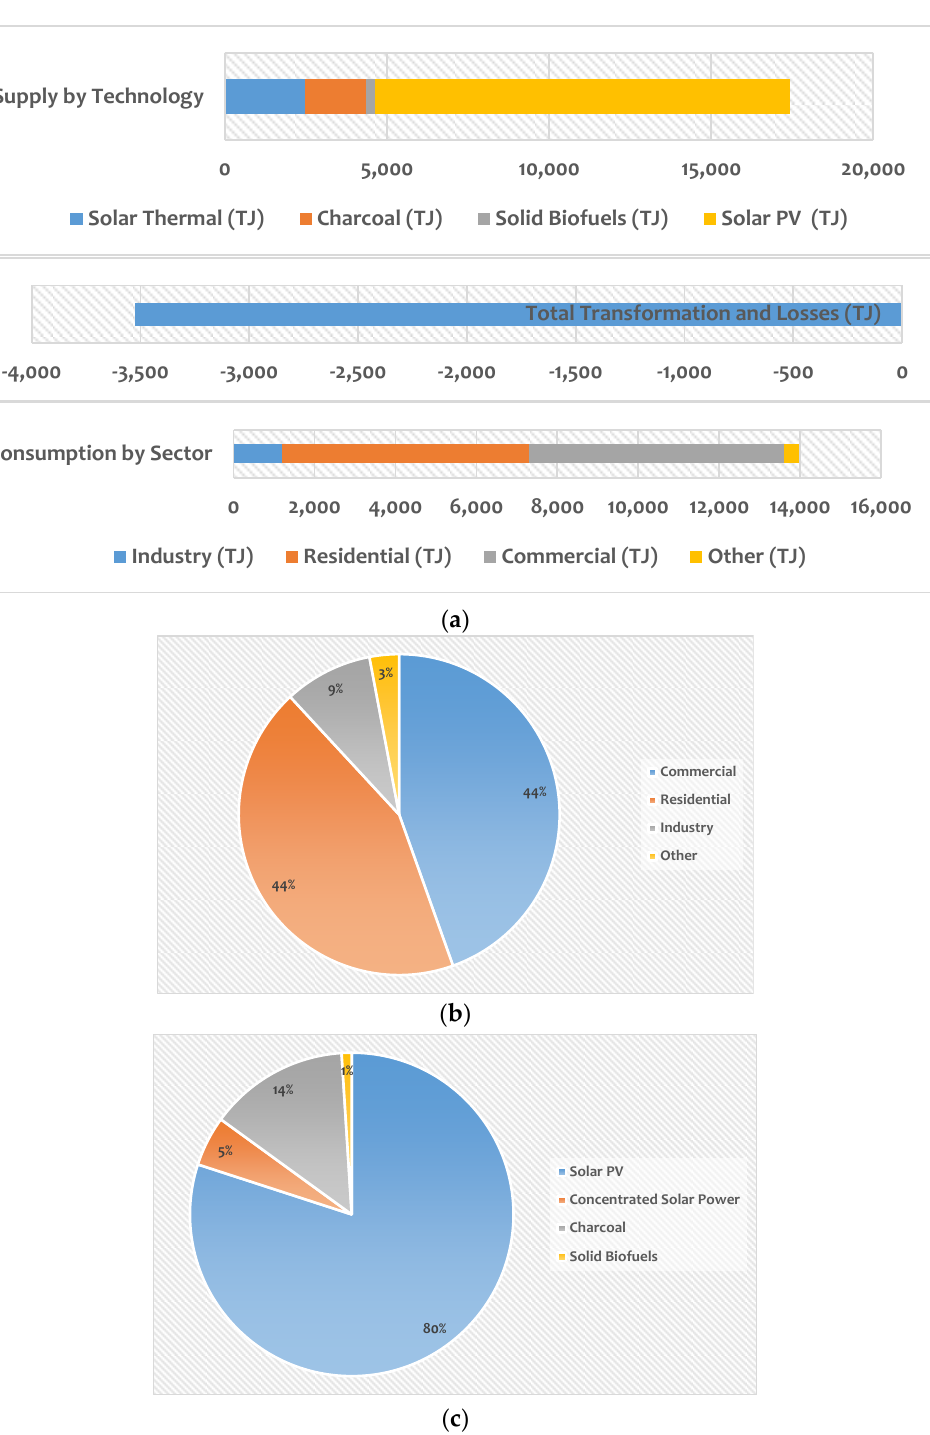
Figure 4. ( a ) Renewable energy balance in the UAE (2019). Data were collected from [15]; ( b ) final renewable energy demand by UAE economic sector (2019). Data were collected from [16]; ( c ) final renewable energy demand by energy generation technology (2019). Data were collected from [16].